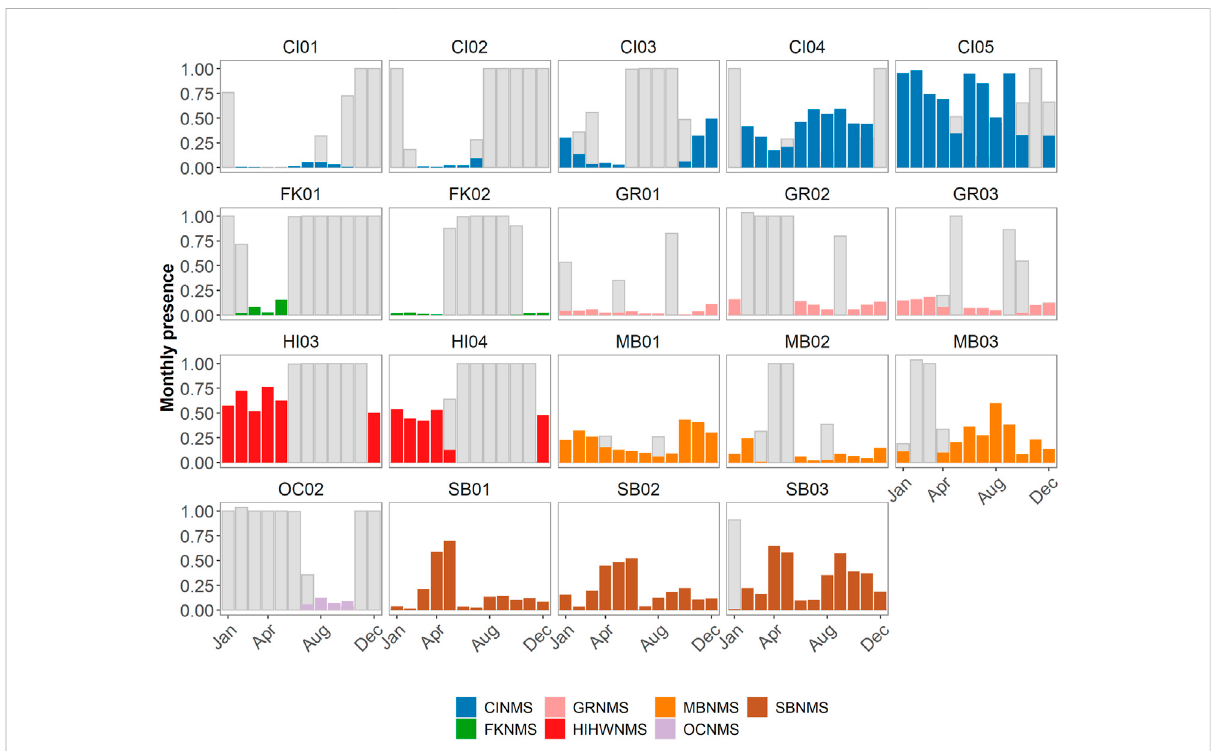
FIGURE 6 Monthly presence of delphinids at each site within a sanctuary expressed as a ratio (0 – 1) where the number of hours of positive presence are normalized by the number of hours in a month. These are then color coded by sanctuary (CINMS = Channel Islands National Marine